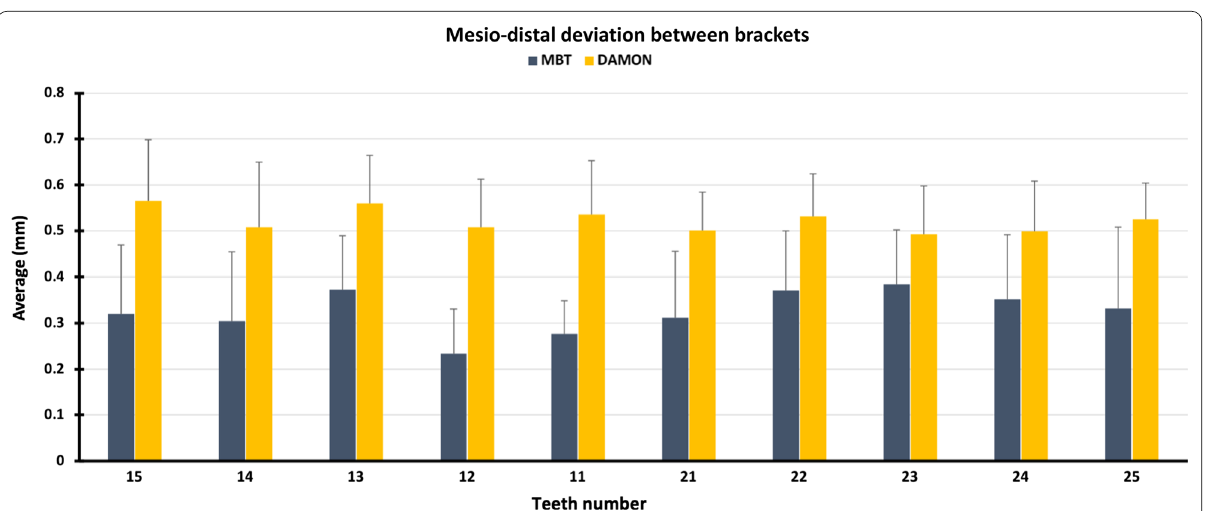
Fig. 8 Differences in mesio-distal positioning on each tooth between direct and indirect methods using MBT and Damon